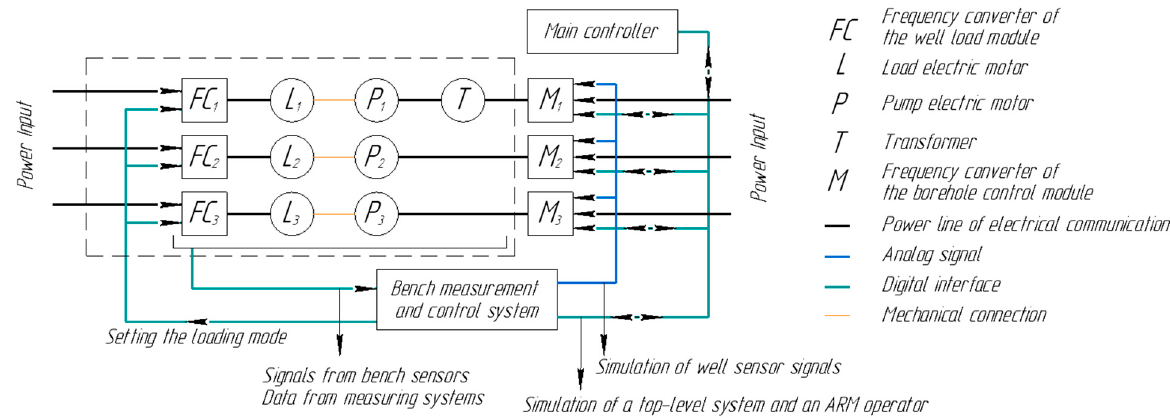
Figure 5. Stand for testing a well cluster control station.